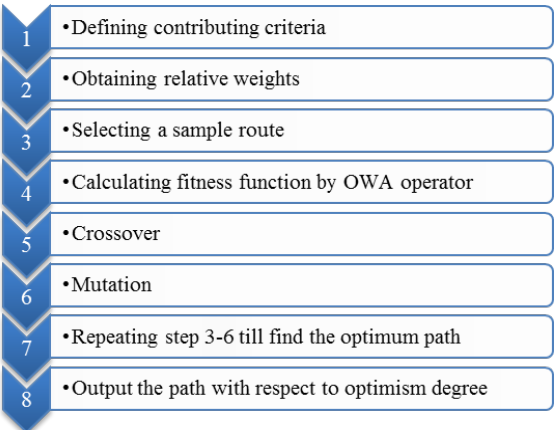
Figure 5. Steps that are done in this research